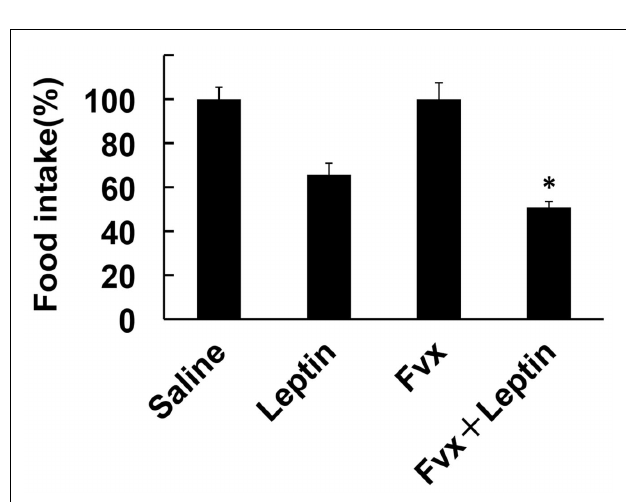
FIGURE 5 | Effect of fluvoxamine on leptin-induced food intake. ob/ob Mice were treated with fluvoxamine (Fvx) along with leptin and analyzed food intake.The effect of leptin on food intake were presented as percentage of saline vs. leptin or fluvoxamine vs. fluvoxamine + leptin. Fluvoxamine significantly enhanced the efficiency of the leptin’s action on inhibiting food intake. * P < 0.05 compared with